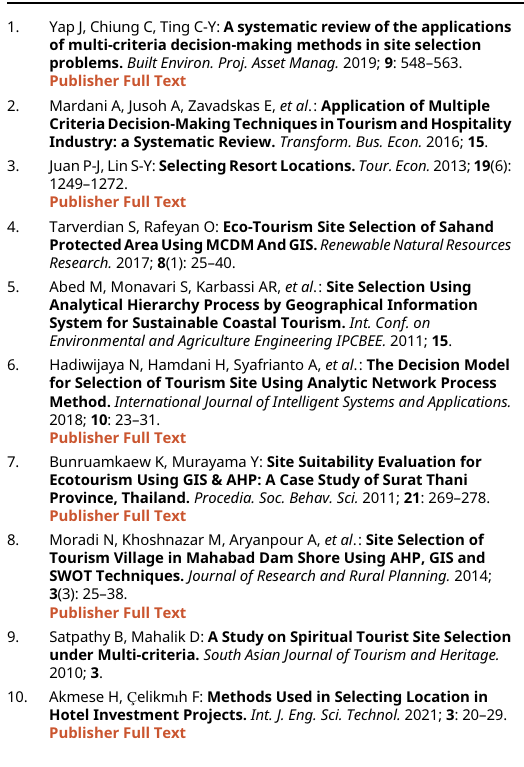
Figshare: Application of the expert knowledge-based fuzzy MCDM models for selection of the tourism development site: the case of Azerbaijan https://doi.org/10.6084/m9.figshare.c.5871563.v3